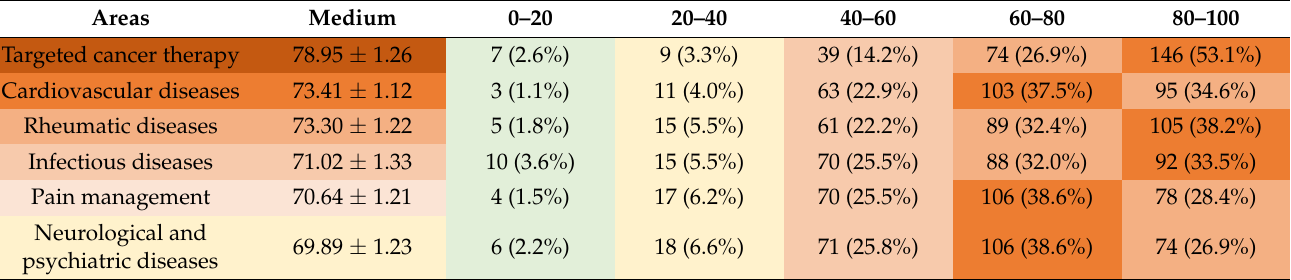
Table 3. Value of PGx testing in different treatment areas (scale 0–100).